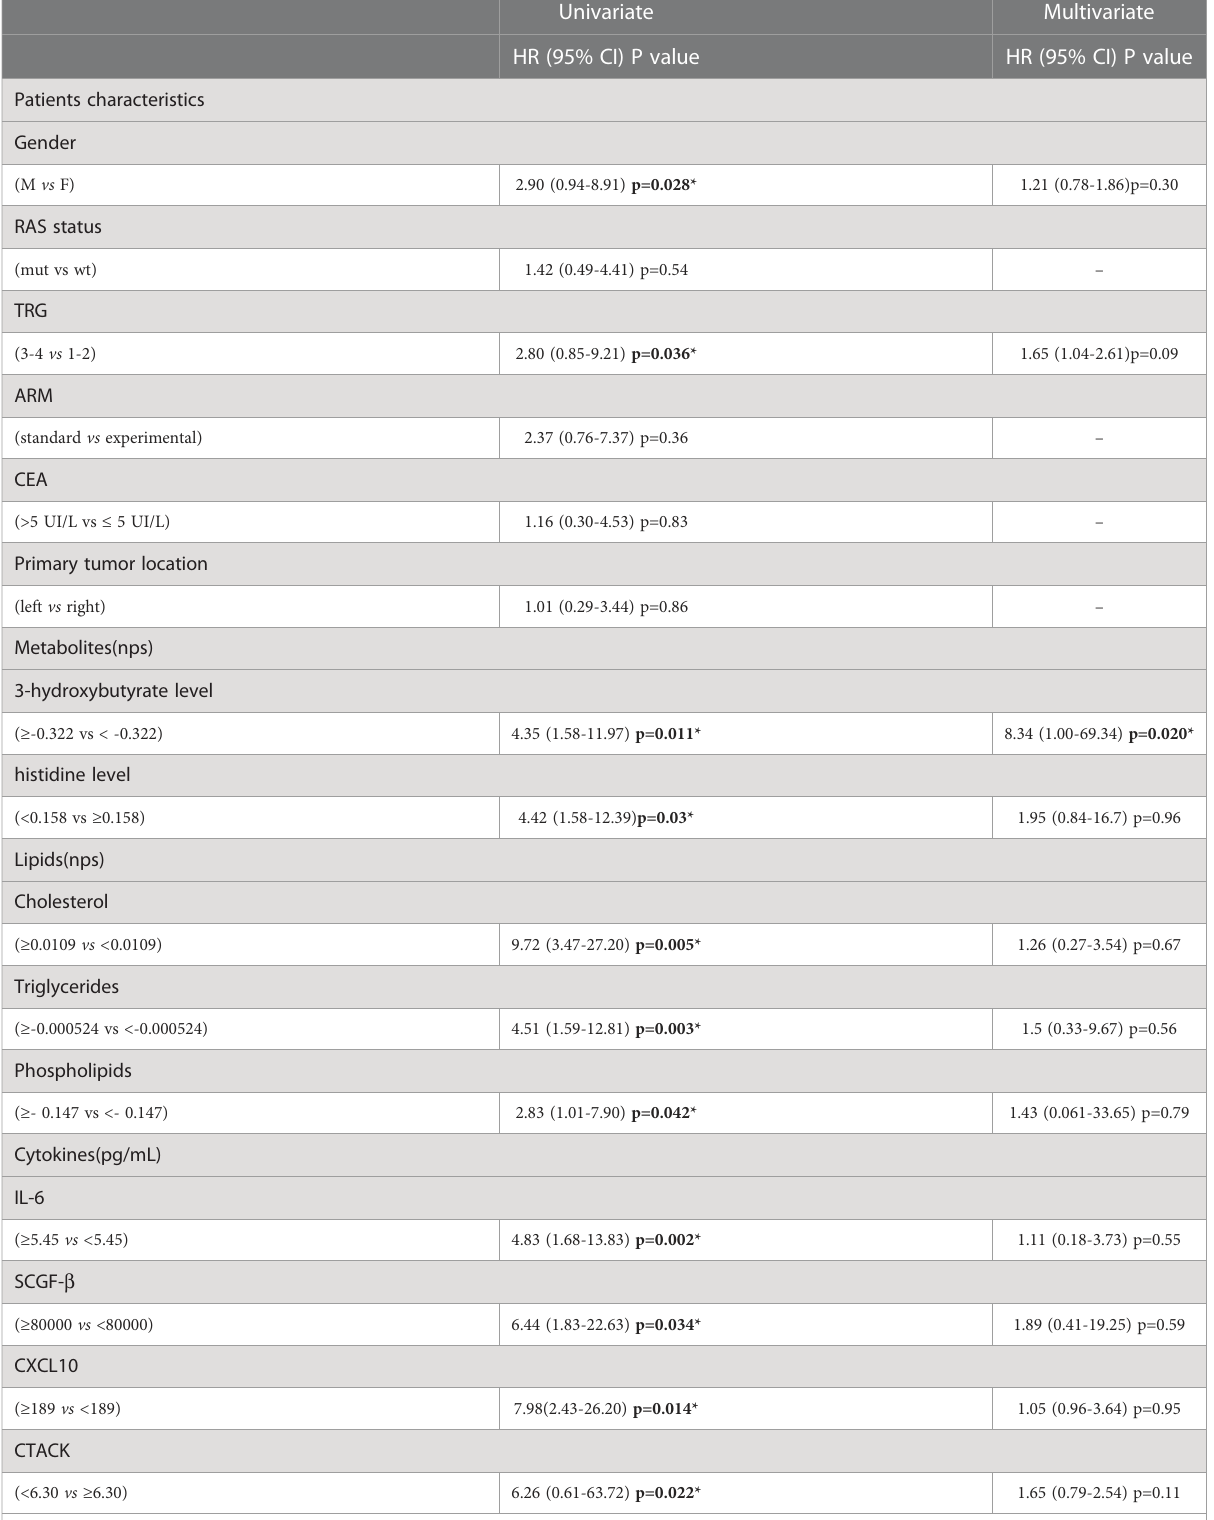
TABLE 2 Univariate and Multivariate analyses of baseline patients characteristics, metabolites, lipids and cytokines for disease free survival